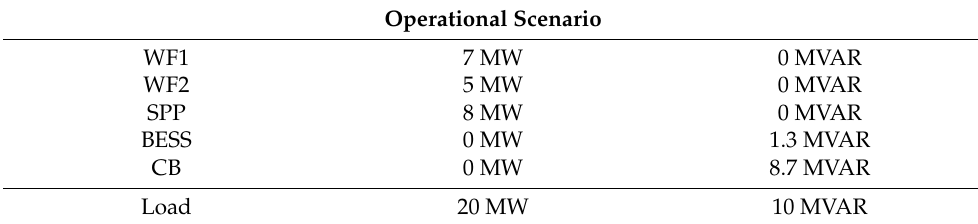
Table 1. Studied operational scenario.